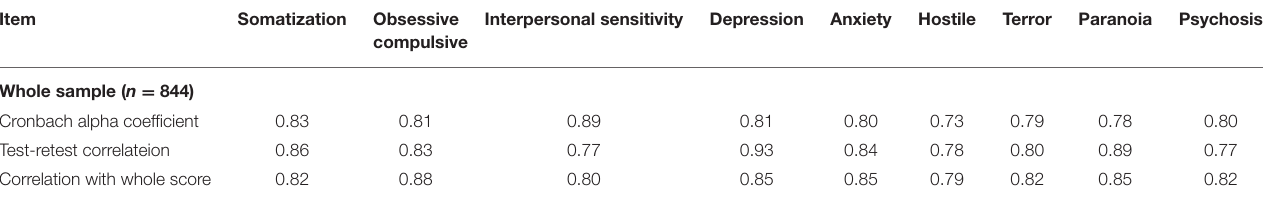
TABLE 1 | Validity and reliability of the SCL-90